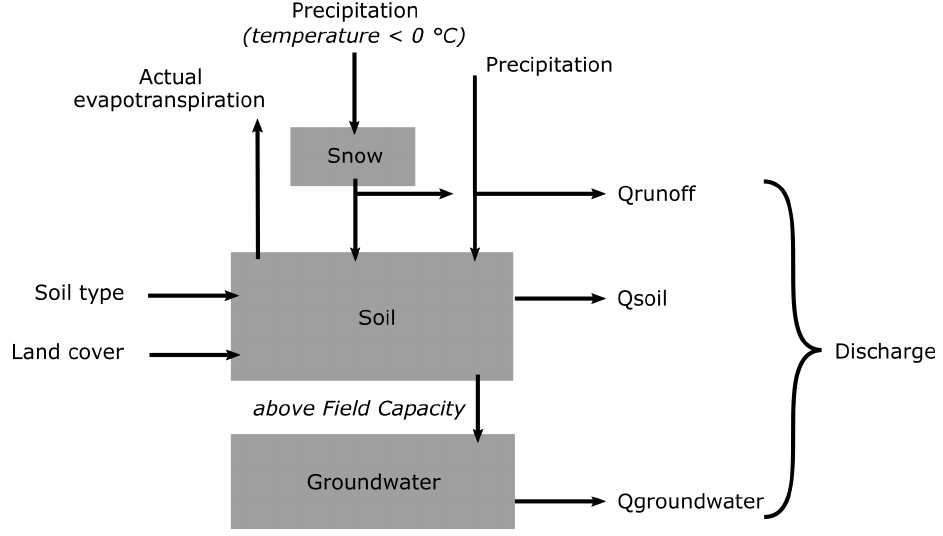
Figure A1. Schematic structure of the STREAM water balance model (based on Aerts et al., 1999). Table A1. List of the hydrological and meteorological stations used for the calibration of STREAM for the Dijle River and Grote Nete River basins. KMI: Belgian Royal Meteorological